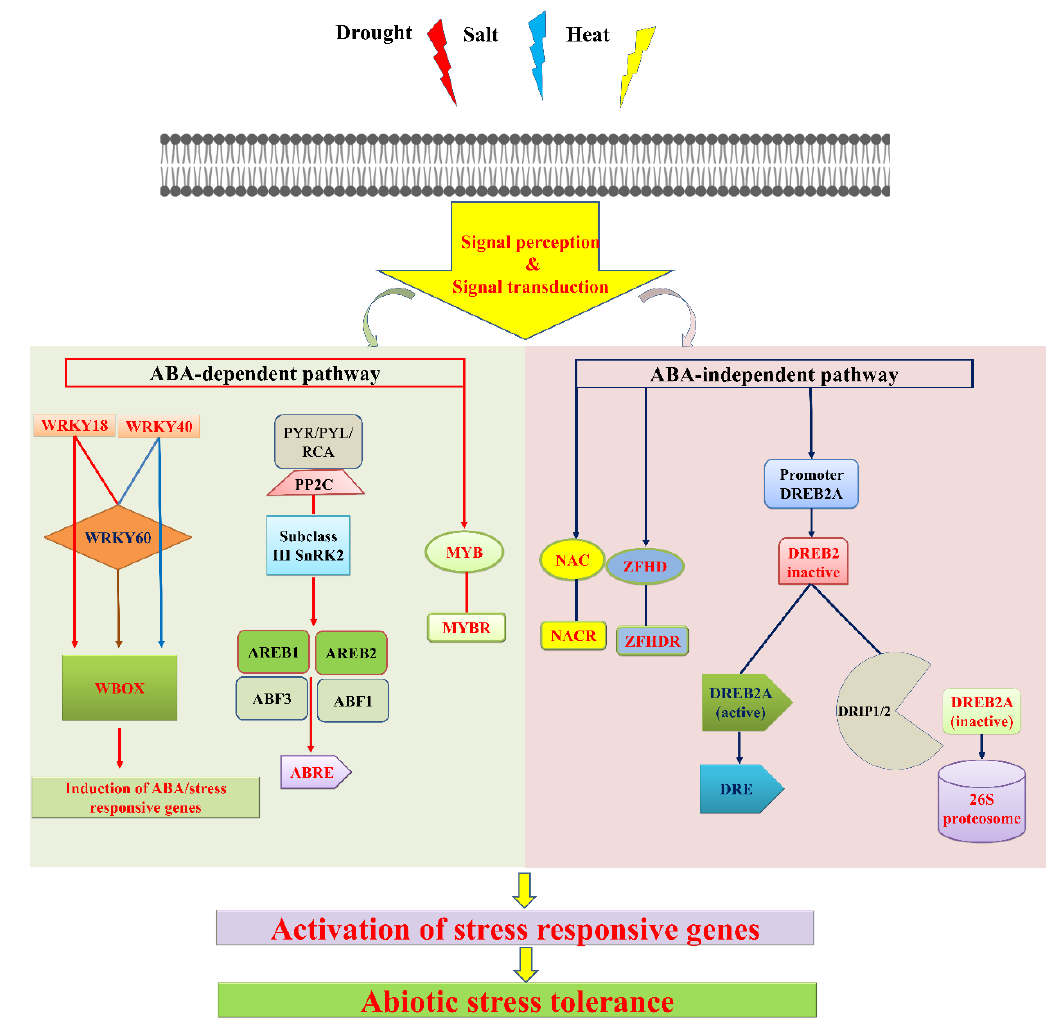
Figure 4. Schematic representation describes the ABA-dependent and independent signaling path- ways involved in acquiring drought, salt and heat stress responses, and tolerance. ABA—abscisic acid; ABRE-ABA-responsive element; AREB-ABRE-binding protein; ABFs-ABRE-binding factors; DREB2-DRE-/CRT-binding protein 2; DRE-dehydration-responsive element; SnRK2-SNF1-related kinase 2; DRIP1-DREB2A-interacting protein 1; MYB-MYB proto-oncogene transcription factor; NAC—no apical meristem transcription factor; PP2C—protein phosphatases 2C; PYR—pyrabactin resistance 1; PYL—pyr1-like; RCA—regulatory components of ABA receptor; ZFHDR—zinc finger homeodomain transcription